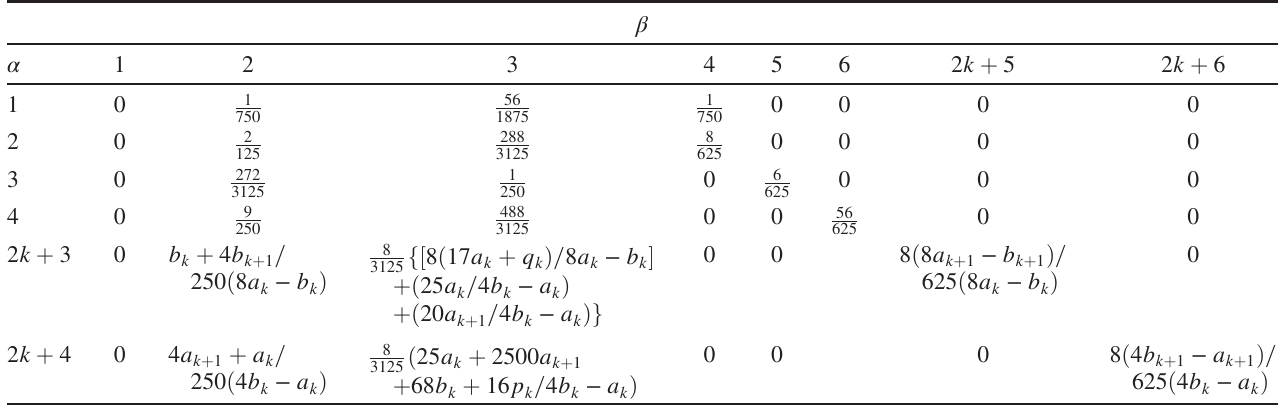
for the middle module graph and for k ≥ 1 ; β